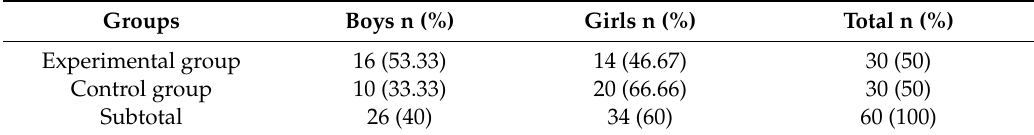
Table 1. Study groups by